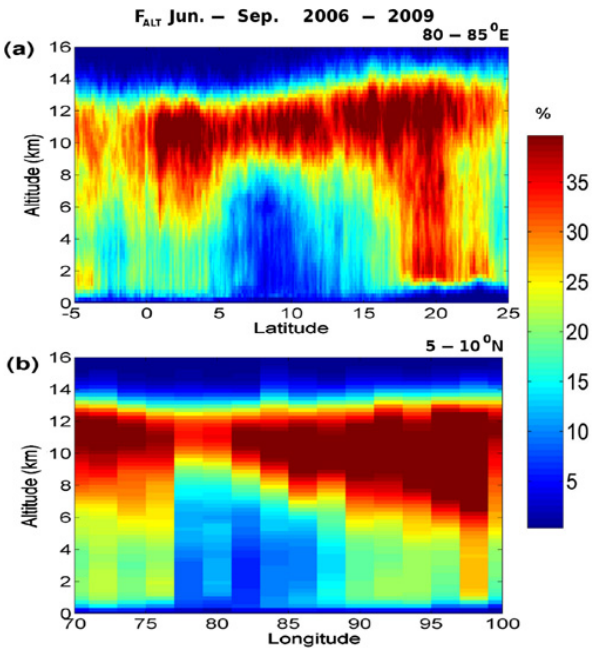
Fig. 2. (a) Four-year (2006–2009) average seaonal mean latitude- altitude cross section of the frequency of occurrence of clouds ( F ALT , expressed in percentage) during ASM along 80–85 ◦ E. (b) Same as (a) but for the longitude-altitude cross section averaged along 5–10 ◦ N.